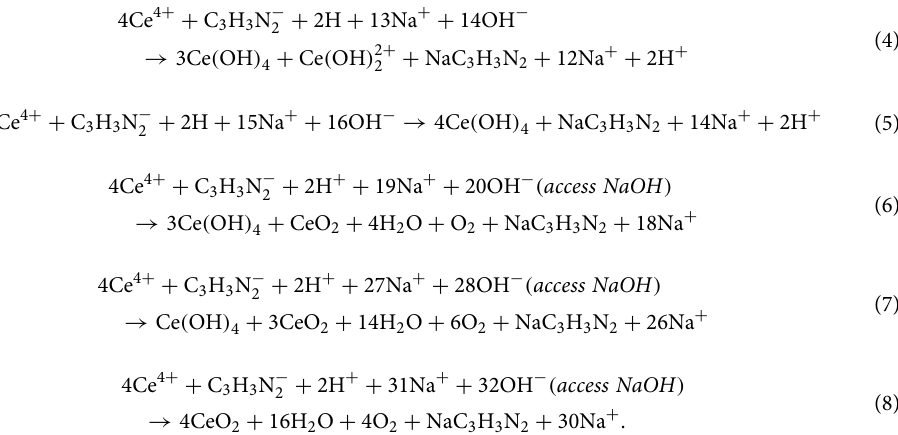
Fig. 2a. The addition of imidazole (C 3 H 4 N 2 ) into the solution in Eq. (1) as a catalyst enhances the solubility of Ce 4+ , and the solution then exhibits a transparent and bright yellow color, as shown in Eq. (2) and beaker (iii) of Fig. 2a. Between pH values of 4.0 and 5.0 (region I), the addition of NaOH as a synthesis termination titrant produces the Ce(OH) yellow color, as shown in Eq. (3)–(5), beakers (i) and (iii) of Figs. 2b, and S3a–c. However, between the pH values of 5.5 and 6.0, further addition of the NaOH titrant generates a mixture of Ce(OH) 4 and CeO 2 abrasives; thus,